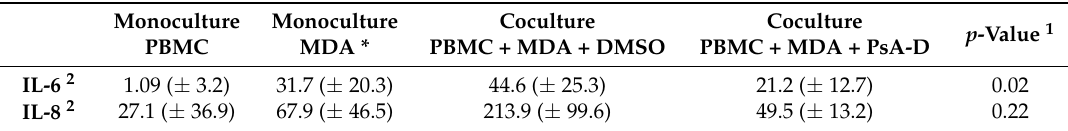
Table 1. Inhibition of cytokine expression in coculture of peripheral blood mononuclear cells (PBMC) and MDA-MB-231 cells after pseudopterosin treatment.